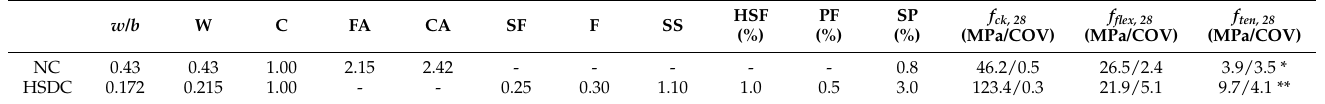
Table 4. Proportions of the mixtures.